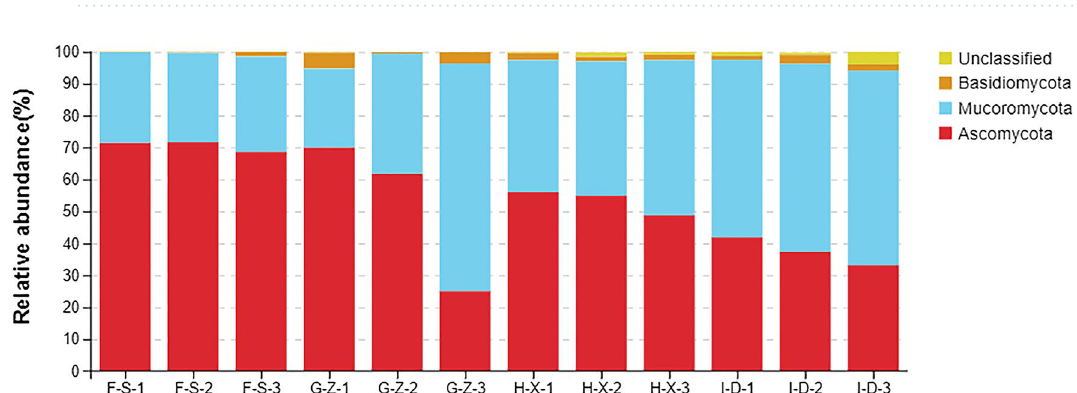
Figure 3. Stack diagram showing the species distribution of fungi in pit mud from F-S, G-Z, H-X and I-D at the phylum